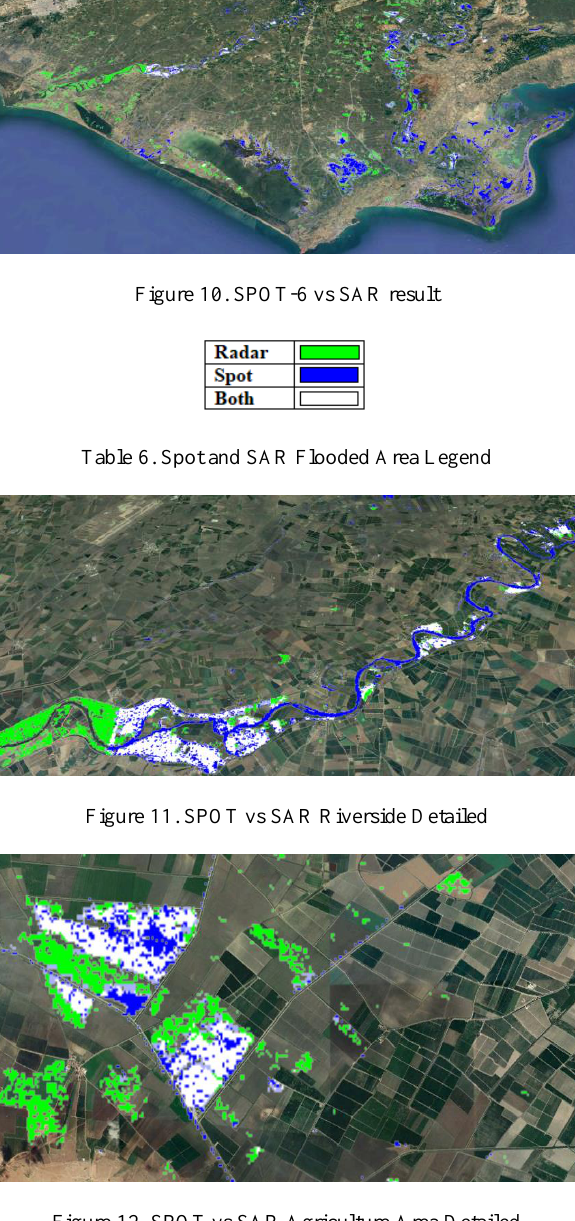
Figure 12. SPOT vs SAR Agriculture Area